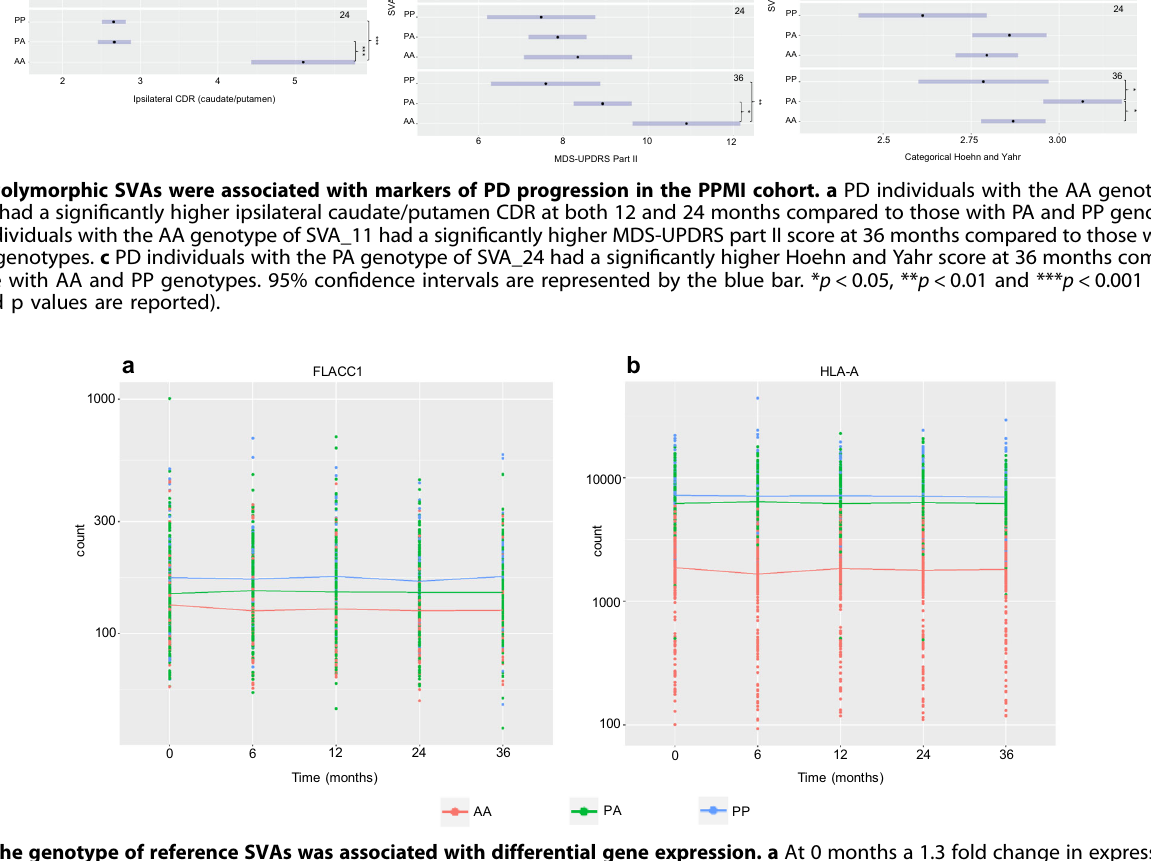
Fig. 3 The genotype of reference SVAs was associated with differential gene expression. a At 0 months a 1.3 fold change in expression of FLACC1 was signi fi cantly associated with SVA_11 genotype when comparing PP to AA (FDR p = 0.04) and at 36 months a 1.4 fold change in expression when comparing PP to AA (FDR p = 2.22 × 10 − 5 ). b At 0 months a 3 fold change in expression of HLA-A was signi fi cantly associated with SVA_24 genotype when comparing PA to AA (FDR p = 1.90 × 10 − 78 ) and a 3.7 fold change in expression when comparing PP to AA (FDR p = 6.22 × 10 − 51 ). At 36 months a 2.5 fold change in expression of HLA-A was signi fi cantly associated with SVA_24 genotype when comparing PA to AA (FDR p = 7.51 × 10 − 60 ) and a 3.6 fold change in expression when comparing PP to AA (FDR p = 2.49 × 10 − 38 ). n =